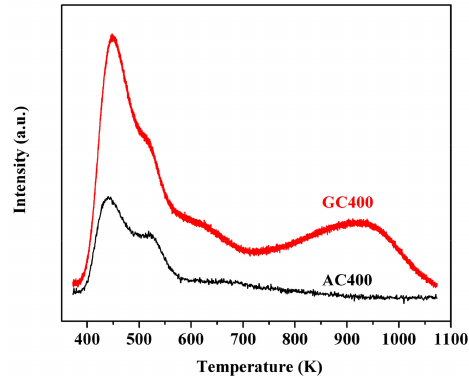
Figure 3. NH 3 -TPD results of two sulfonated carbon